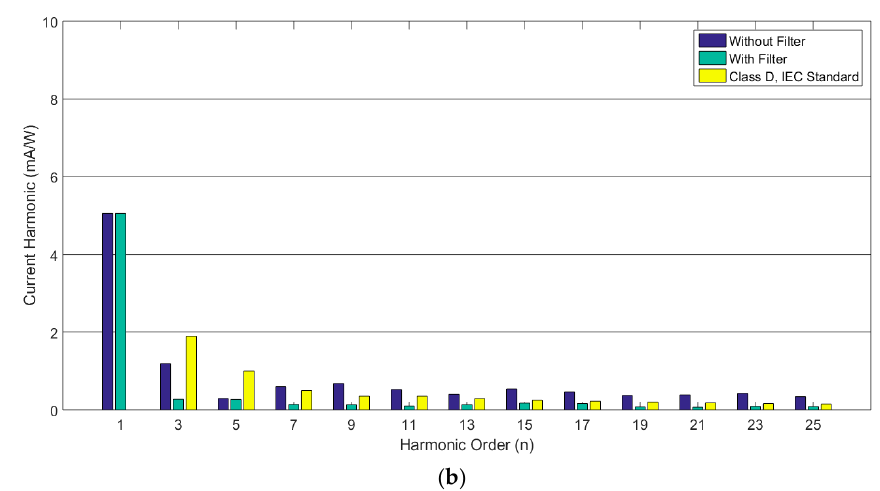
Figure 16. Comparison of harmonic magnitude for lighting system with and without filter including IEC standard. ( a ) LED lamp with internal driver including Class C IEC standard; ( b ) LED lamp with internal driver including Class D IEC standard.